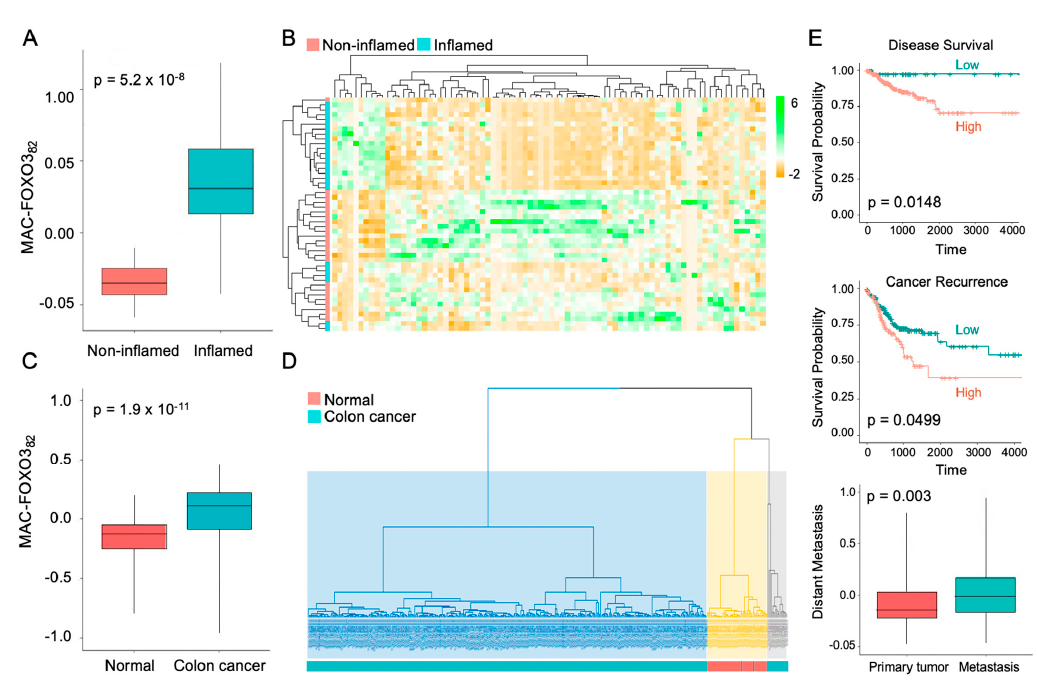
Figure 4. MAC-FOXO3 82 signature in IBD and colon cancer. ( A , B ) Principal component analysis (PCA) of inflamed IBD and matched non-inflamed control transcriptomes with the MAC-FOXO3 82 signature was performed to estimate variation between samples. Two-axis values of the PCA showed the MAC-FOXO3 82 significantly differentiated inflamed IBD from matched non-inflamed control tissue. DEGs representing MAC-FOXO3 82 signature on y-axis and IBD samples on x-axis ( n = 23, GSE4183, p = 5.2 × 10 − 8 ). Hierarchical clustering, as shown by representative heatmap, revealed two distinct clusters of IBD samples separated by MAC-FOXO3 82, differentiating between inflamed IBD and matched non-inflamed control transcriptomes. DEGs representing MAC-FOXO3 82 signa- ture on x-axis and human IBD samples on y-axis ( n = 23, GSE4183). ( C , D ) Principal component anal- ysis (PCA) of human colon cancer and matched normal (control) colonic tissue transcriptomes with the MAC-FOXO3 82 signature was performed to estimate variation between samples. Two-axis val- ues of the PCA showed MAC-FOXO3 82 significantly differentiated human colon cancer from matched normal (control tissue) ( n = 498, TCGA, p = 1.9 × 10 − 11 ). Hierarchical clustering, as shown by representative heatmap, revealed two distinct clusters of human colon cancer samples separated by MAC-FOXO3 82 differentiating between human colon cancer and matched normal control tran- scriptomes ( n = 498, TCGA). ( E ) Increased MAC-FOXO3 82 signature presence in colon cancer pa- tients is associated with poor survival rates ( p = 0.0148), increased risk of cancer recurrence ( p = 0.0499), and distant metastasis ( p = 0.003) (Kaplan–Meier survival analysis). 2.4. Expression of Select FOXO3-Dependent Genes in Peritoneal Macrophages Next, we identified the top DEGs specific to FOXO3-deficient peritoneal macro- phages relative to control shown in a heatmap, Figure 5A, many of which are also repre- sented in MAC-FOXO3 82 . These DEGs were validated in FOXO3-deficient macrophages (vs WT) by qPCR, and their status was determined in publicly available transcriptomes of IBD and human colon cancer cohorts. It is important to consider that these DEGs may vary in expression in different subtypes of macrophages or in other cell types. We found these DEGs with established roles in human colonic inflammation and tumorigenesis such as Interleukin 1 Beta (IL-1B), C-X-C Motif Chemokine Receptor 2 (CXCR2), S100 Calcium- binding Protein A8 (S100A8), S100 Calcium-binding Protein A9 (S100A9), and Triggering Receptor Expressed On Myeloid Cells 1 (TREM1) to be significantly increased in FOXO3-